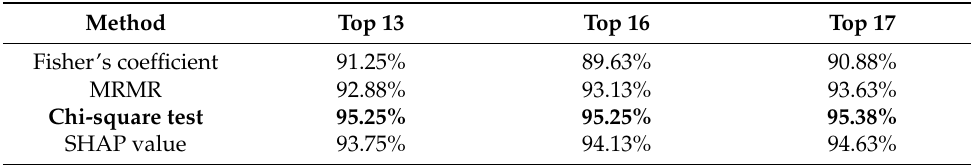
Table 10. AF detection accuracy based on the ranked